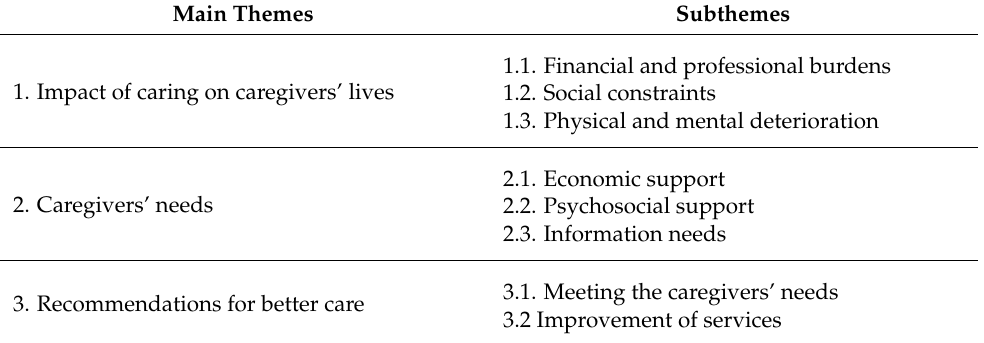
Table 2. Main themes and